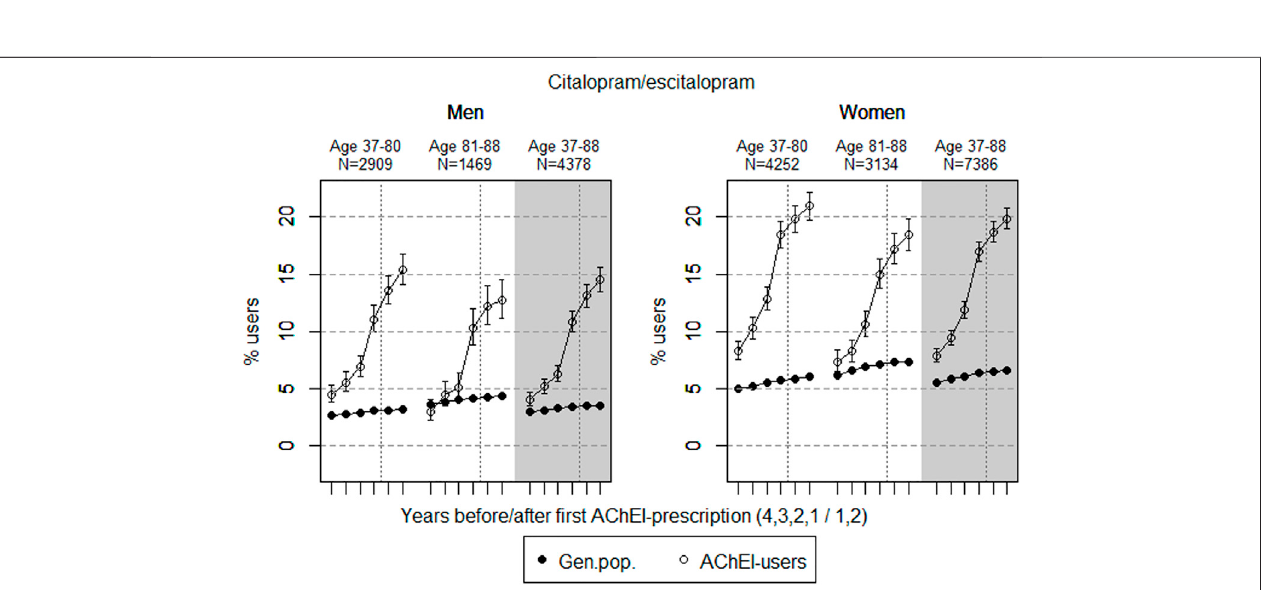
FIGURE 2 | Open circles: Proportion of men and women, respectively, of the study population who fi lled at least one prescription of citalopram or escitalopram (ATCN06AB04or10)inthe4 yearsbeforeAChEIinitiationandthe2 yearsafterwith95%con fi denceintervals.Bullets:Thecorrespondingageadjustedproportioninthe general population. Dashed vertical lines indicate AChEI initiation. The size of each age group in the study population is given on top.